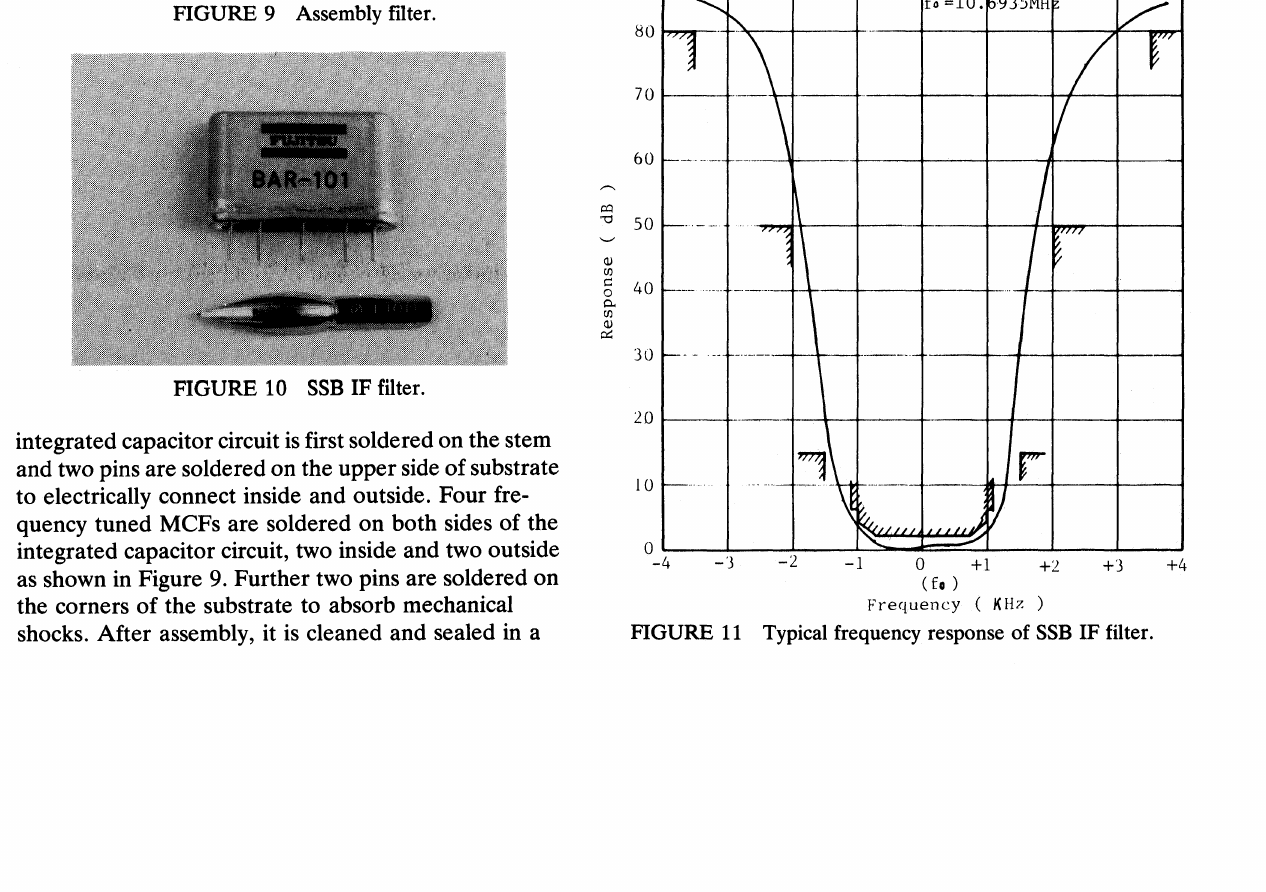
FIGURE 8 Assembly of SSB IF filter.